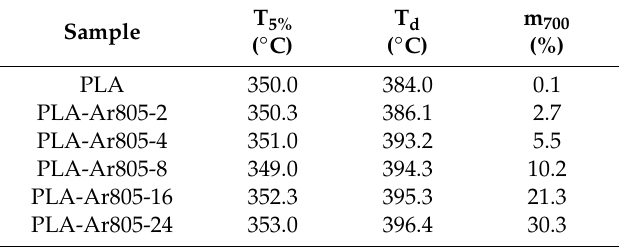
Table 2. Results of TGA analysis on PLA-based nanocomposites.